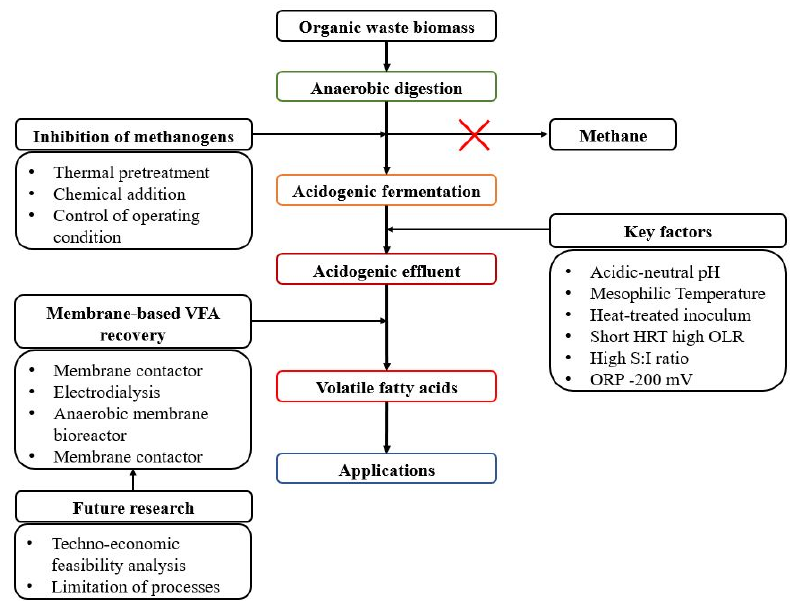
Figure 6. Overview diagram of VFA production process.